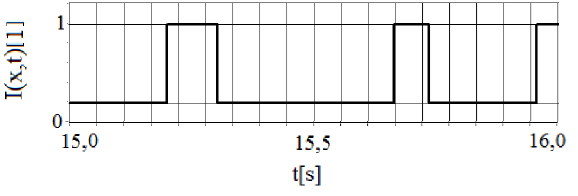
Fig. 6 . Indicator function I ( t ), [3]